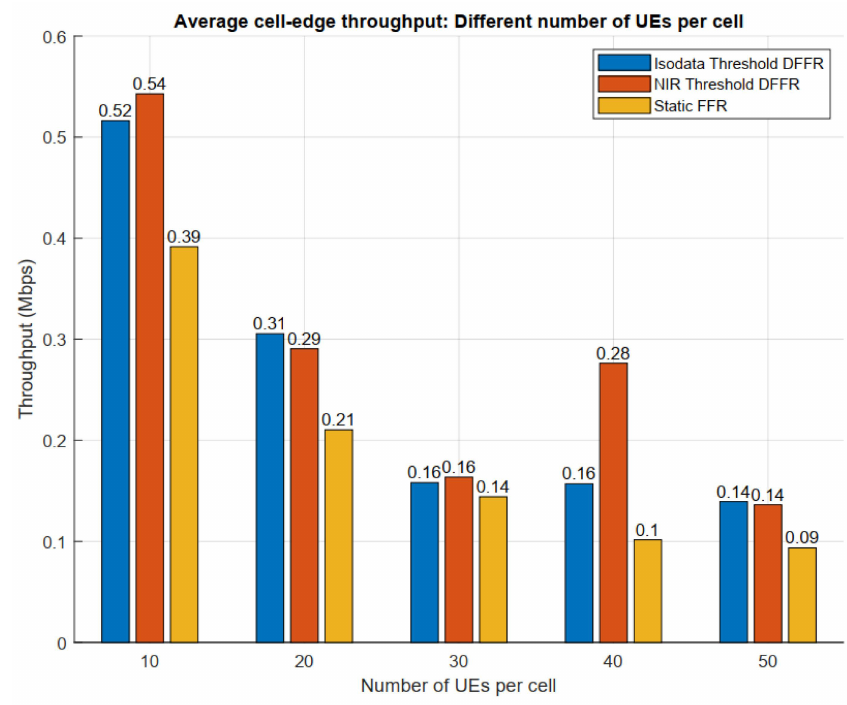
Figure 13. Average edge throughput for a number of user equipment per cell.